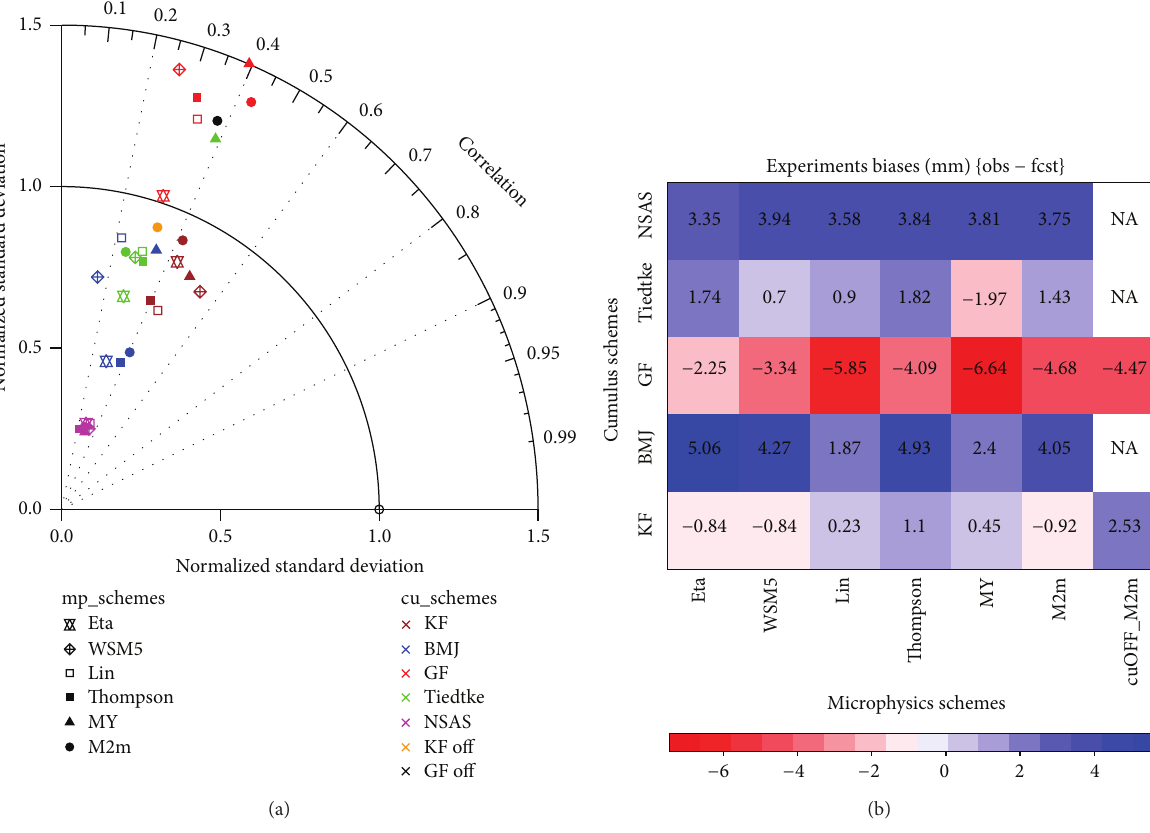
Figure 6: Taylor diagram (a) and experiments biases (b) for 6 hours of cumulative precipitation and for all experiments. The symbols (a) refer to microphysics schemes while the colors refer to cumulus schemes. Valid for 0000 UTC, 2 May 2012. Biases computed as observed minus each experiment forecast. Positive (blue) values indicate that the forecast underestimates observation